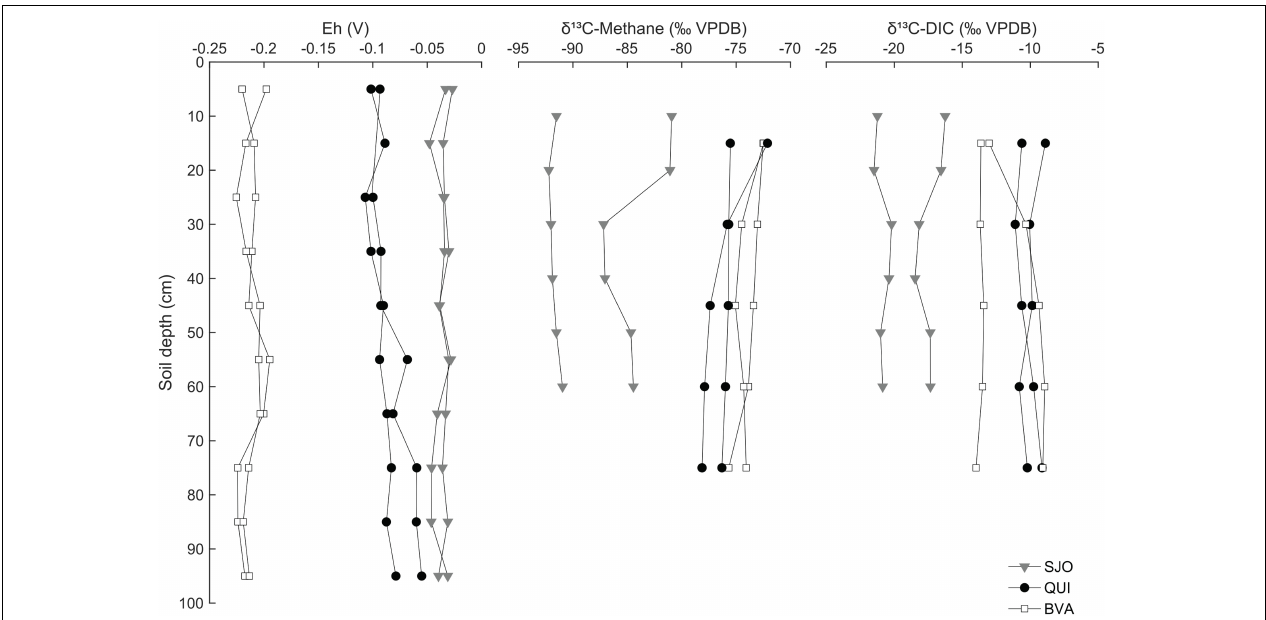
FIGURE 3 | Redox gradient and carbon isotope composition of CH 4 and dissolved inorganic carbon along soil profiles of three tropical peatlands (BVA, QUI, SJO). Redox potential (E h ) is based on the ratio of the CH 4 -CO 2 redox couple and soil pH-corrected. VPDB, Vienna Pee Dee Belemnite. Each data point corresponds to one replicate soil